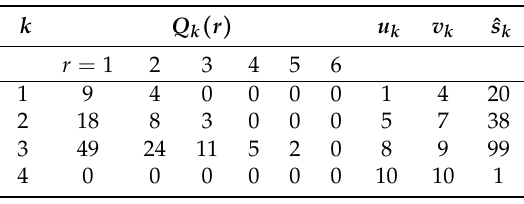
Table 2. The generated ˆ P = 4 sub-sequences for the basis for the example input data with N = 10 as a result of Algorithm 2. The values of Q k ( r ) represent the value of Q ( r ) as given in (9) for the k -th sub-sequence of the basis, defined by the indices u k and v k . The column ˆ s k provides the sum of the values of the input data within the indices u k and v k .